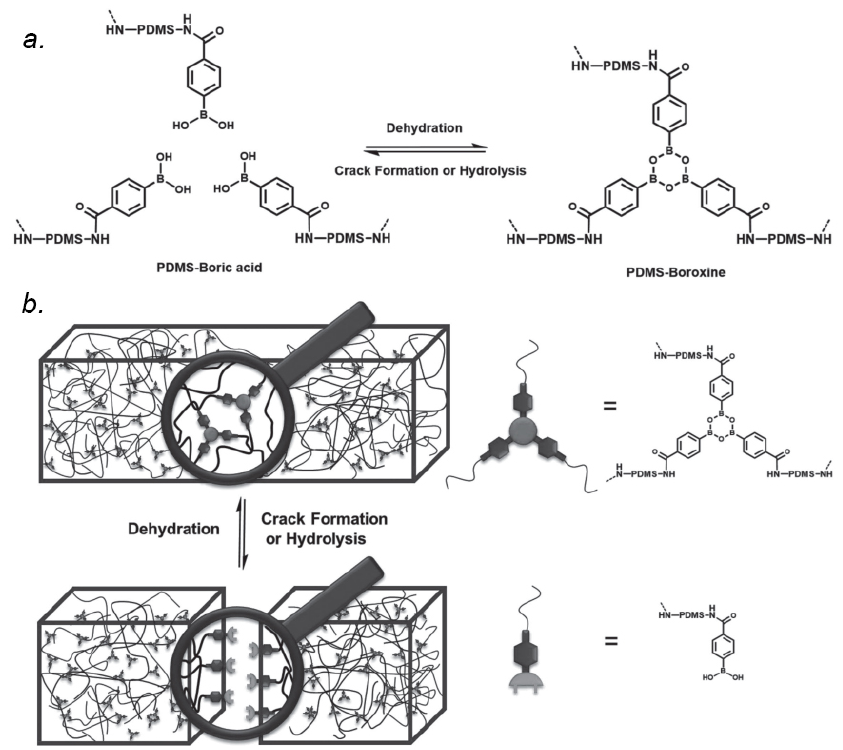
Figure 8. The structure and dynamic process of PDMS ‒ Boroxine ( a ) and the mechanism for the water-enabled healing process ( b ) Reprinted with permission from [7679]. Copyright 1999–2022 John Wiley & Sons, Inc.